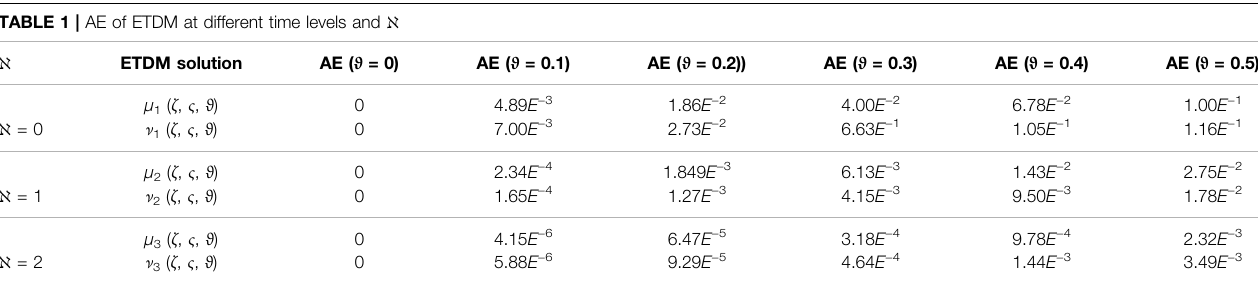
TABLE 1 | AE of ETDM at different time levels and ℵ